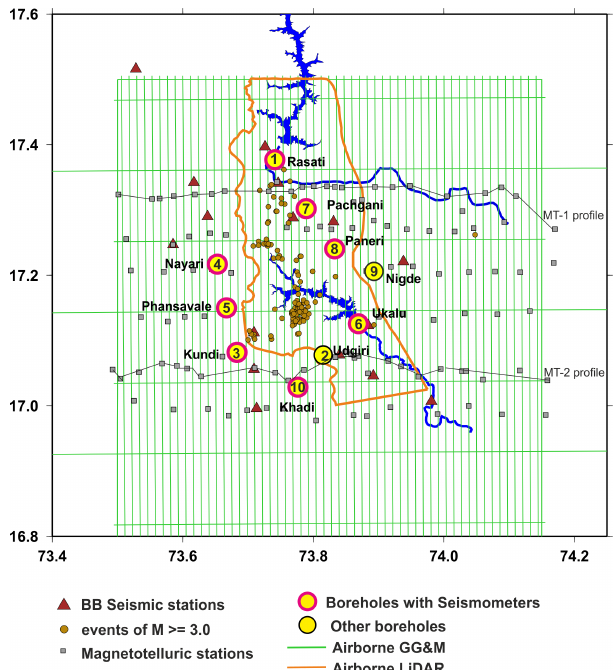
Figure 2. Map of the study area. Green lines indicate the airborne gravity gradiometry and magnetic data flight lines. An orange line encloses the airborne lidar acquisition area. Grey squares indicate MT sites. Red triangles are broadband seismological stations. Num- bered circles indicate the locations of exploratory boreholes which are being drilled and logged. Borehole 2 could not be logged; 9 and 10 are planned. Boreholes in Rasati and Kundi have been instru- mented with three component seismometers at depths of 1522 and 1134m, respectively. The remaining six boreholes are to be instru- mented in the next few months. Brown filled circles indicate earth- quakes of magnitude greater than 3 for the period 2005 to